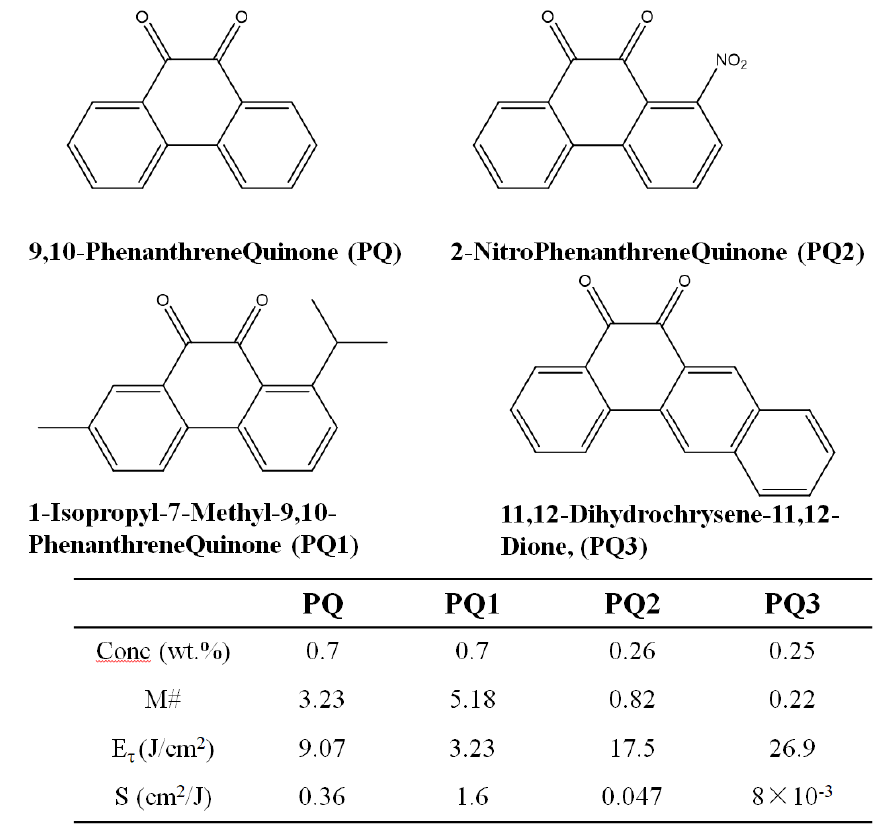
Figure 18. PQ derivatives’ chemical structures and experimental results [122] .